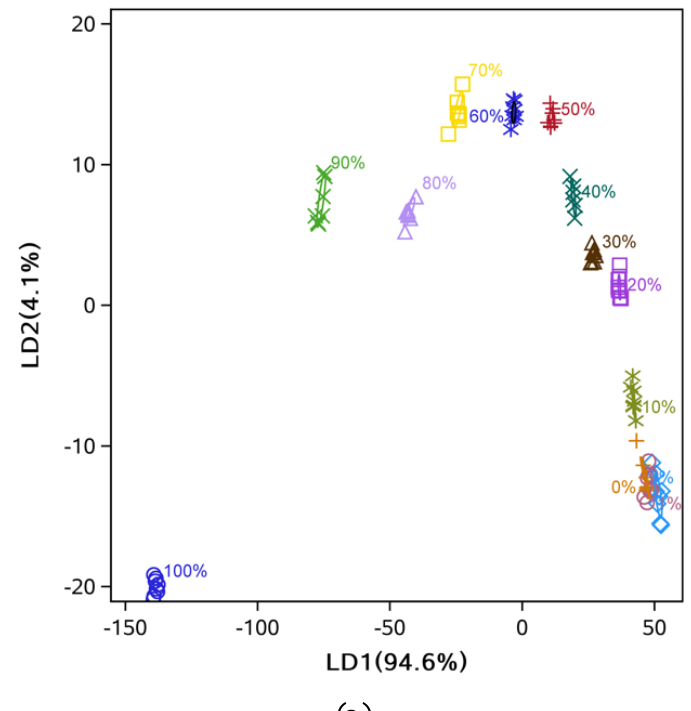
Figure 4. PC1 and PC2 score plot from PCA analysis for mixtures of different sesame oils. ( a ) Hot-pressed sesame oil mixed with refined sesame oil; ( b ) Cold-pressed sesame oil mixed with refined sesame